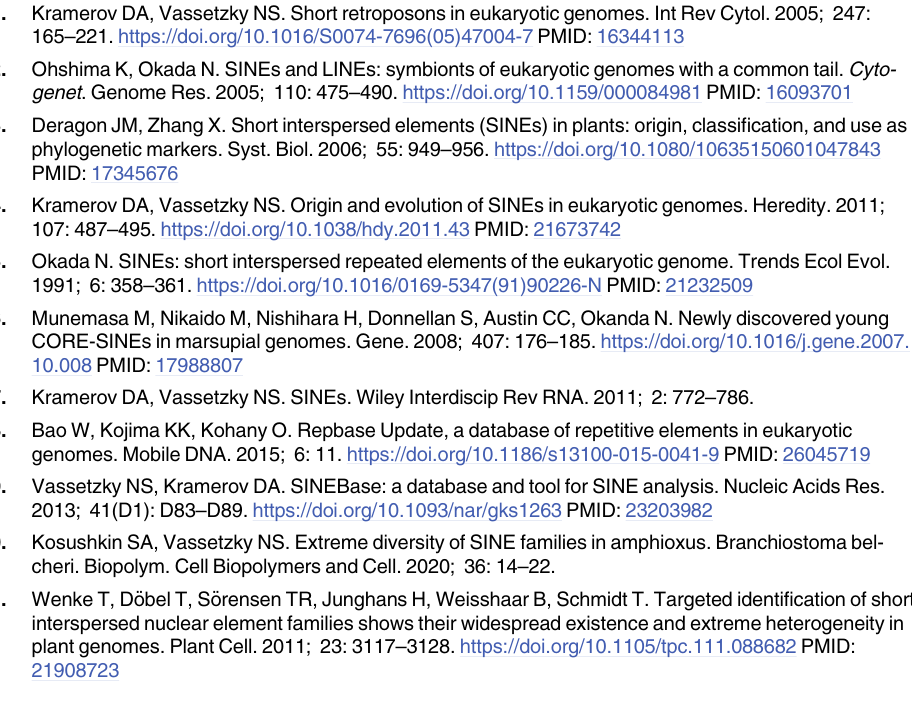
S6 Fig. The result of piRNA reads mapping to the Sbg1, Sbg3 –Sbg6, and Sbg8 consensus sequences. Reads mapped in direct orientation are highlighted in blue, and reads mapped in reverse complement orientation are green. S1 Table. The analysis of 100 genes, for each of which 1000 or more piRNA reads were mapped. F and R represent forward and reverse complement orientations,